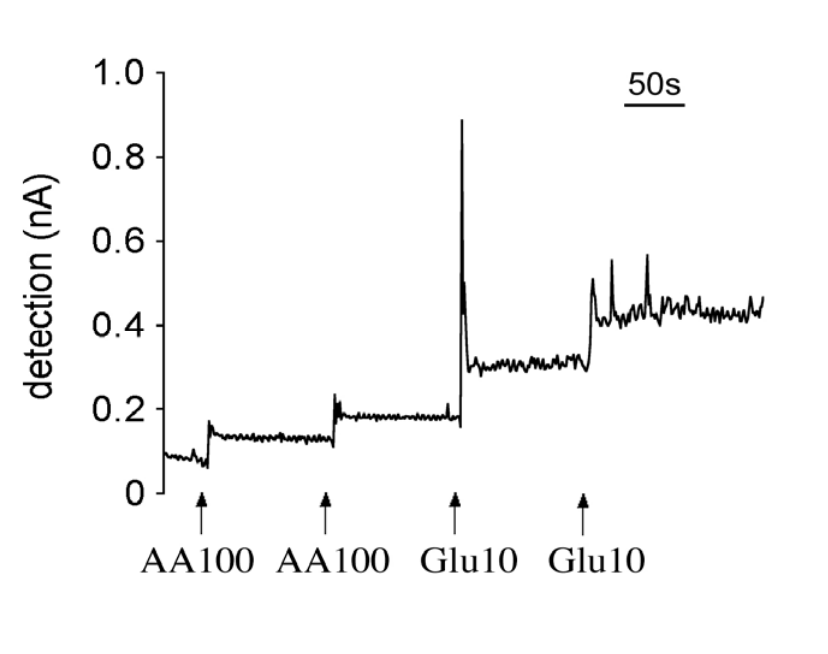
Figure 5. A typical raw amperometric calibration profile of a first generation glutamate microsensor at +700 mV. Calibration was performed in a stirred beaker system. Interfering compounds and analyte were added to beaker after electrical current was